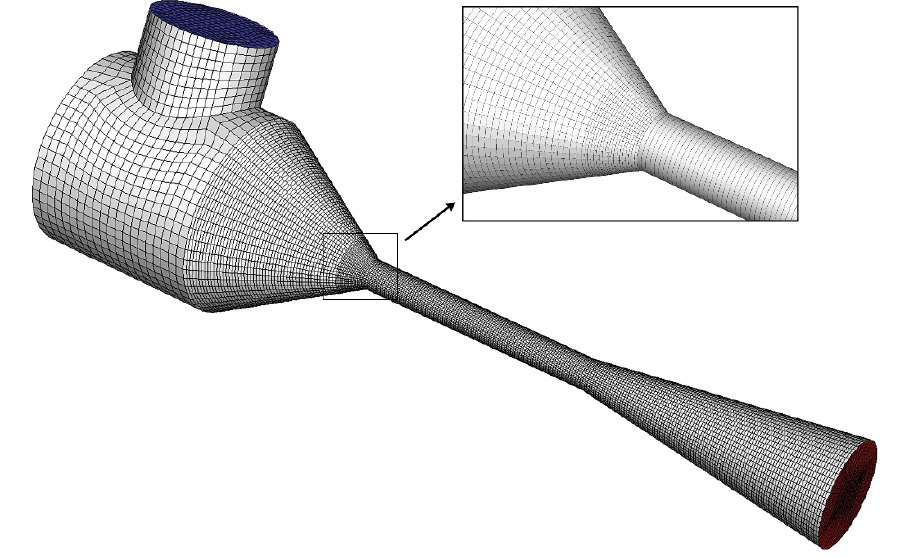
Figure 3. Grid of the two-throat nozzle ejector 3D model.